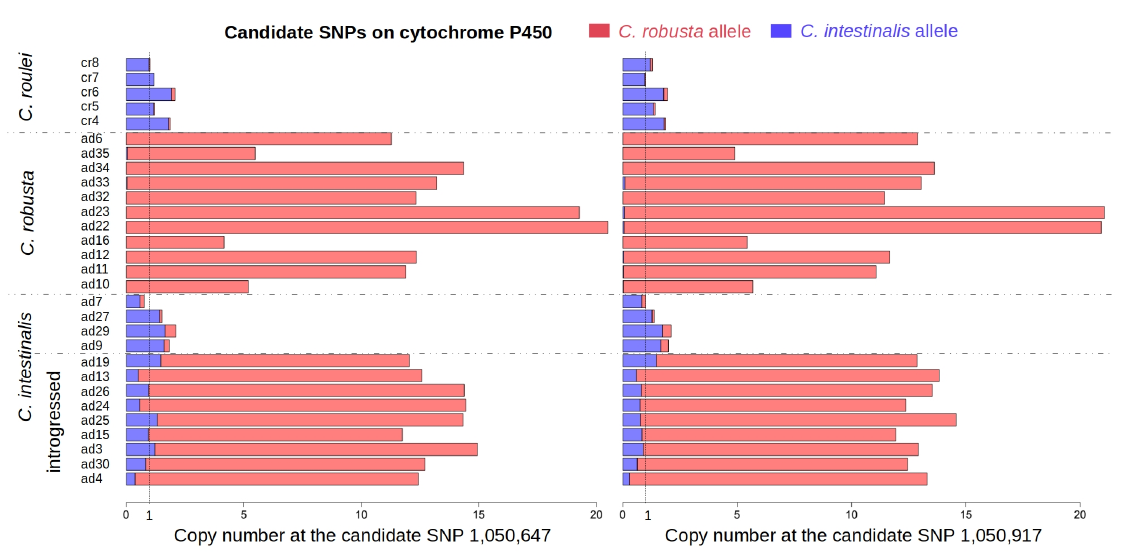
Figure 5: C opy number variation at two candidate SNPs on the cytochrome P450 family 2 subfamily U gene. The two SNPs (labeled with their position in bp) lie in the “missing data region” of the introgression hotspot on chromosome 5. Candidates were defined as having a variant allele fraction, VAF <= 50% in C. intestinalis , a VAF >= 90% in C. roulei and a VAF <= 10% in C. robusta . No candidates were found in the other direction (i.e. with the minor VAF in C. roulei ). Copy number at each SNP was calculated as its allele read depth normalized by the per-site read depth averaged across all sites (excluding sites with less than ten reads) for each individual (labeled on the left). A copy number of one (vertical dashed line) means that the SNP lies on a single-copy locus. Values for the C. robusta allele (red) and the C. intestinalis allele (blue) are separately shown. Read depth was obtained from the bam files. Horizontal dashed lines separate the different species, and C. intestinalis individuals introgressed at the hotspot (see Figure 4 ) were labeled as “introgressed”. Dataset #7 “unfiltered mapping files” was